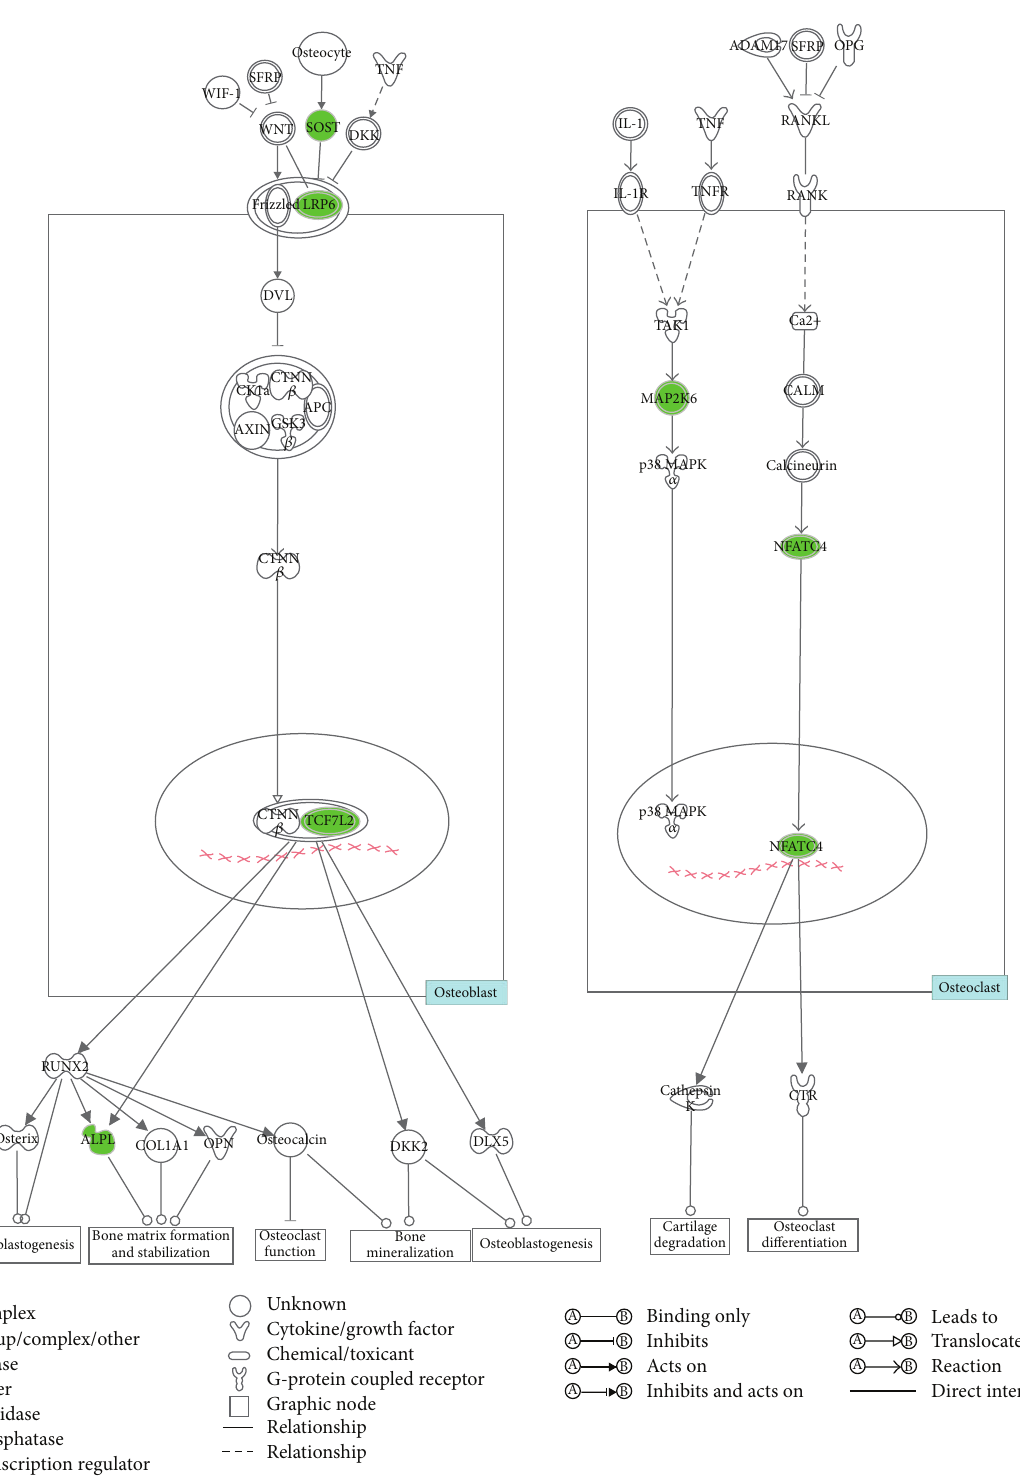
Figure 4: Schematic diagram illustrating the role of osteoblasts and osteoclasts in an antiosteopenic effect of RDE. The downregulated genes appear in green. The white colour indicates the genes that are not user specified but are incorporated into the network through